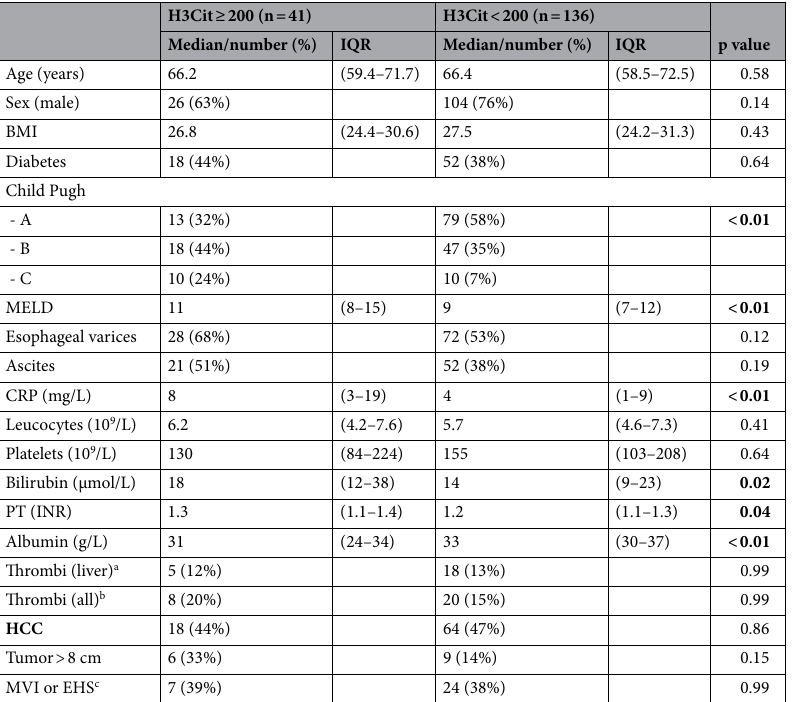
Table 3. Baseline data of the combined cohort of HCC and cirrhosis patients as divided into high or low levels of H3Cit-DNA. H3Cit-DNA of 200 ng/mL equals the 95 th percentile of H3Cit-DNA in healthy controls. a History of thrombi in liver vessels. b History of thrombi, any vessel. c Macrovascular invasion or extrahepatic spread at time of inclusion. Extrahepatic spread includes lymph node invasion and distant